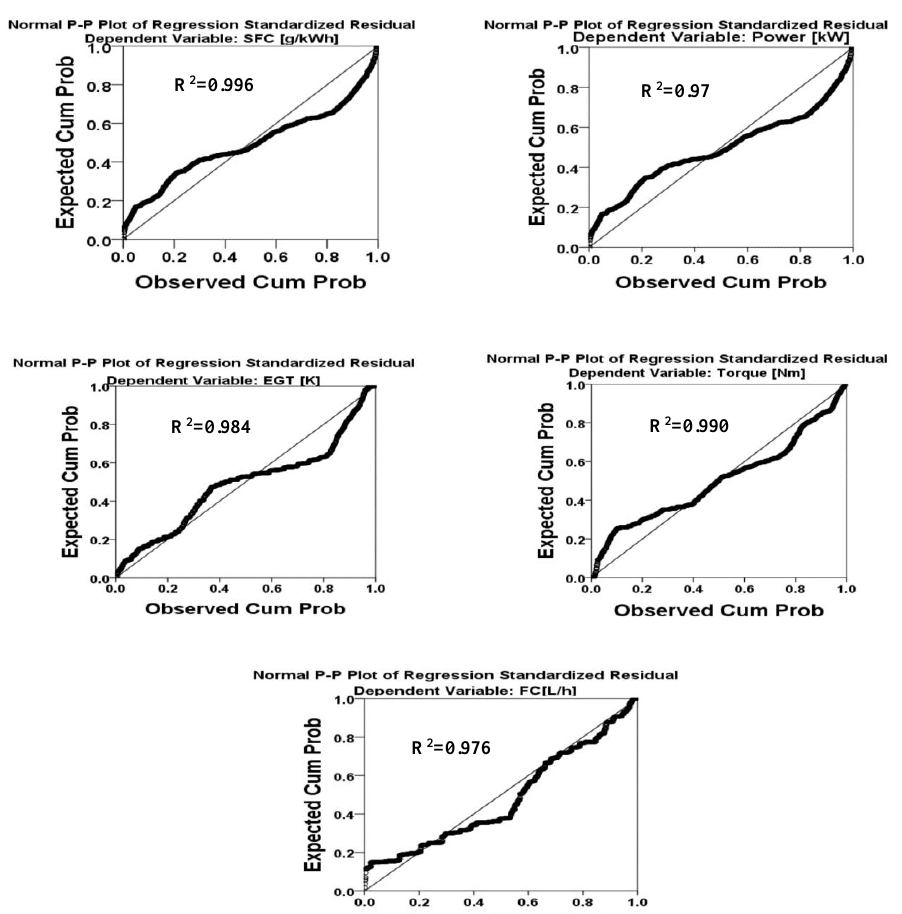
Figure 6. Normal P-Plot of Regression Standardized Residual Dependent Variables.